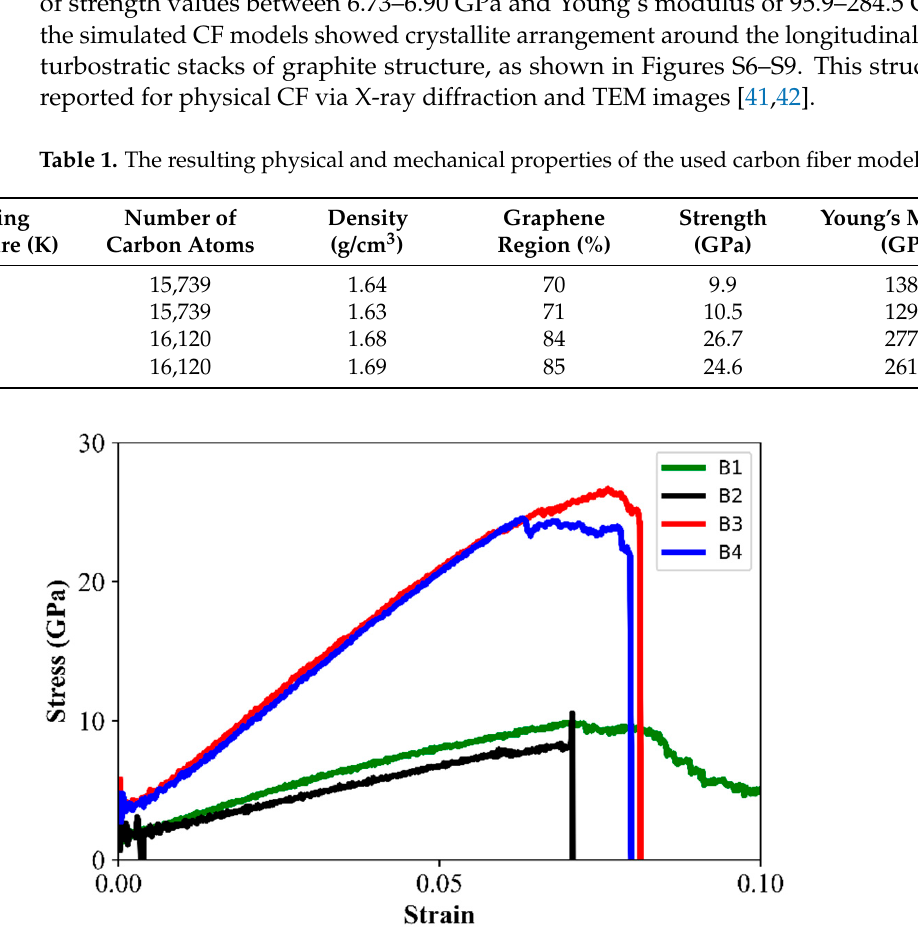
Table 1. The resulting physical and mechanical properties of the used carbon fiber models.